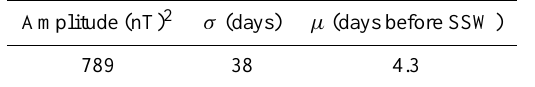
Figure 5. The figure presents the wave power of the lunar tide de- rived from the Huancayo–San Juan pair for the years 1926–1938. The black dashed line shows the threshold level for classifying SSW and non-SSW years.